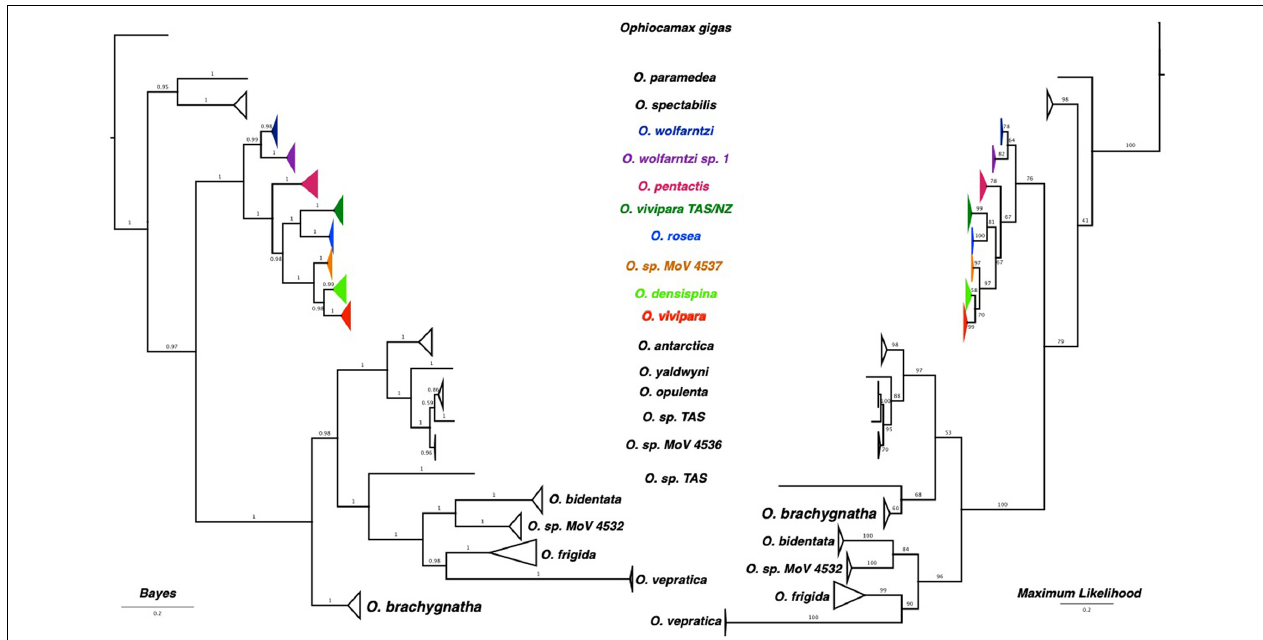
FIGURE 2 | Phylogenetic trees estimated using Bayesian and Maximum Likelihood methods. Node confidence is given by posterior probabilities for the Bayesian tree, and bootstrap